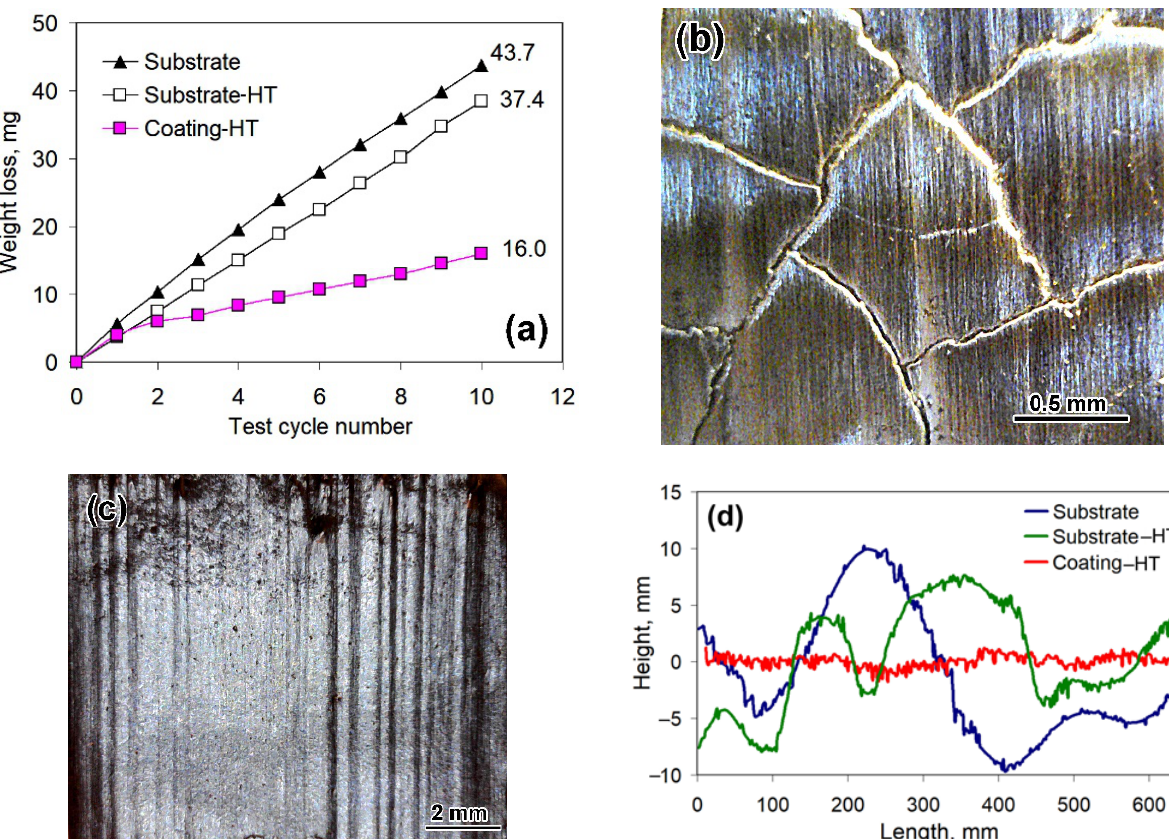
Figure 6. Abrasive wear characteristics of gray cast iron and the coating: ( a ) Cumulative weight loss curves. ( b ) Crack network on the abraded heat-treated coating surface. ( c ) Abraded substrate surface. ( d ) Worn surface profiles.